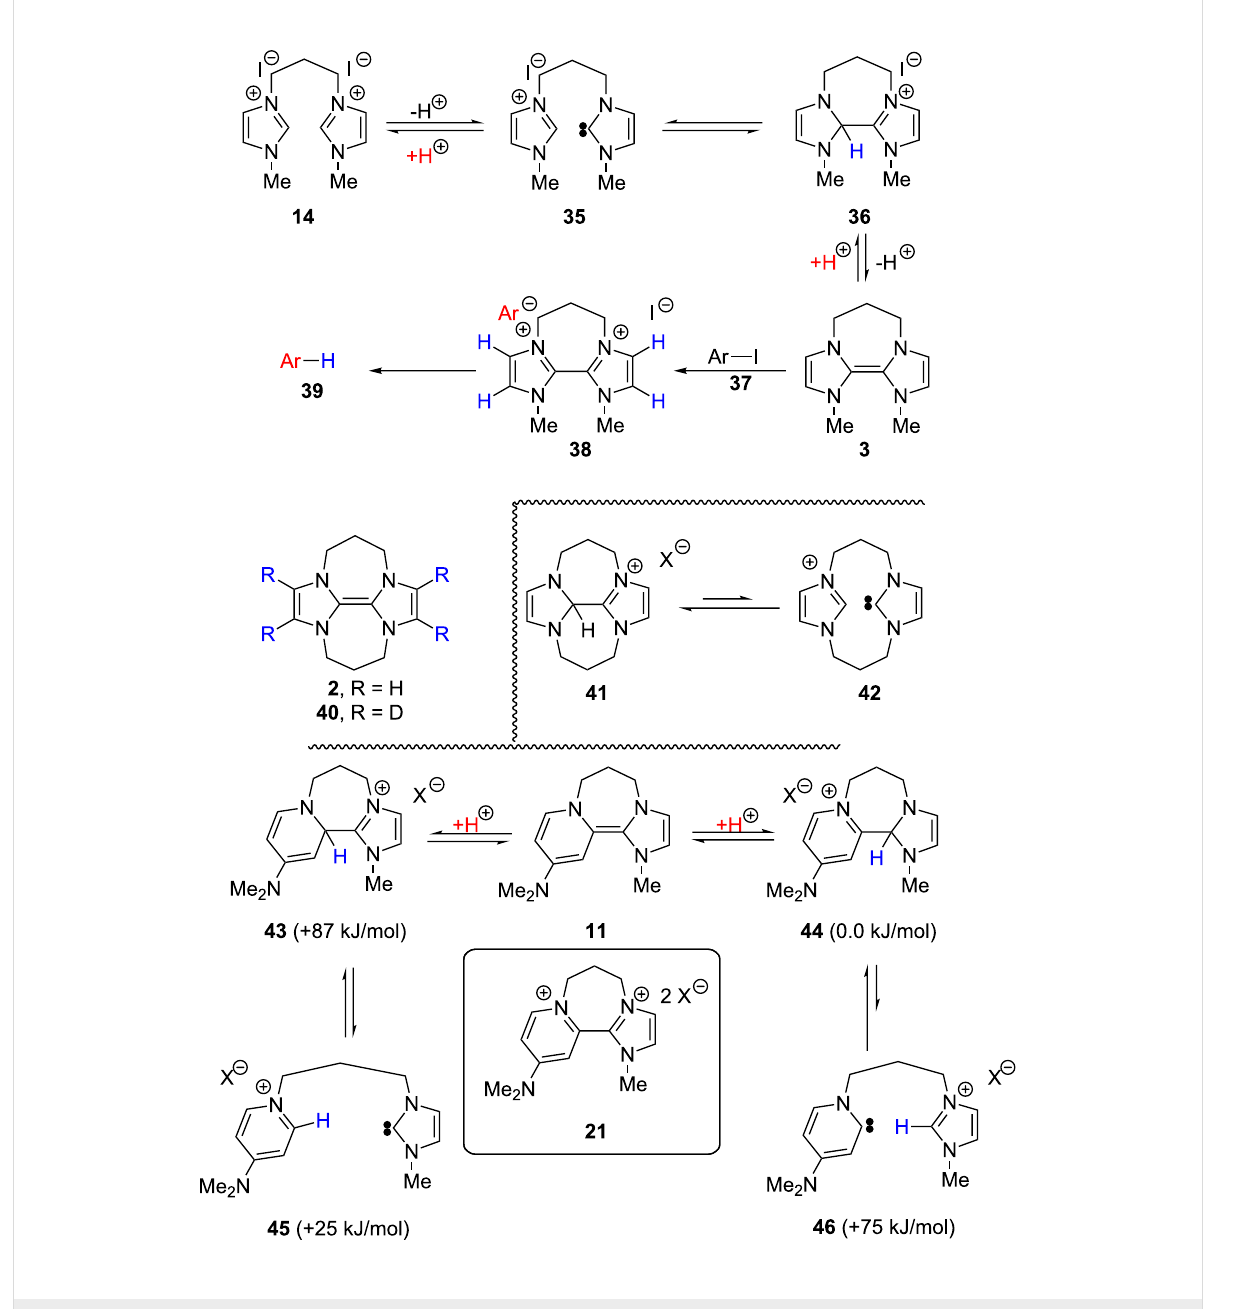
Scheme 6: Rationalisation of effect of excess NaH